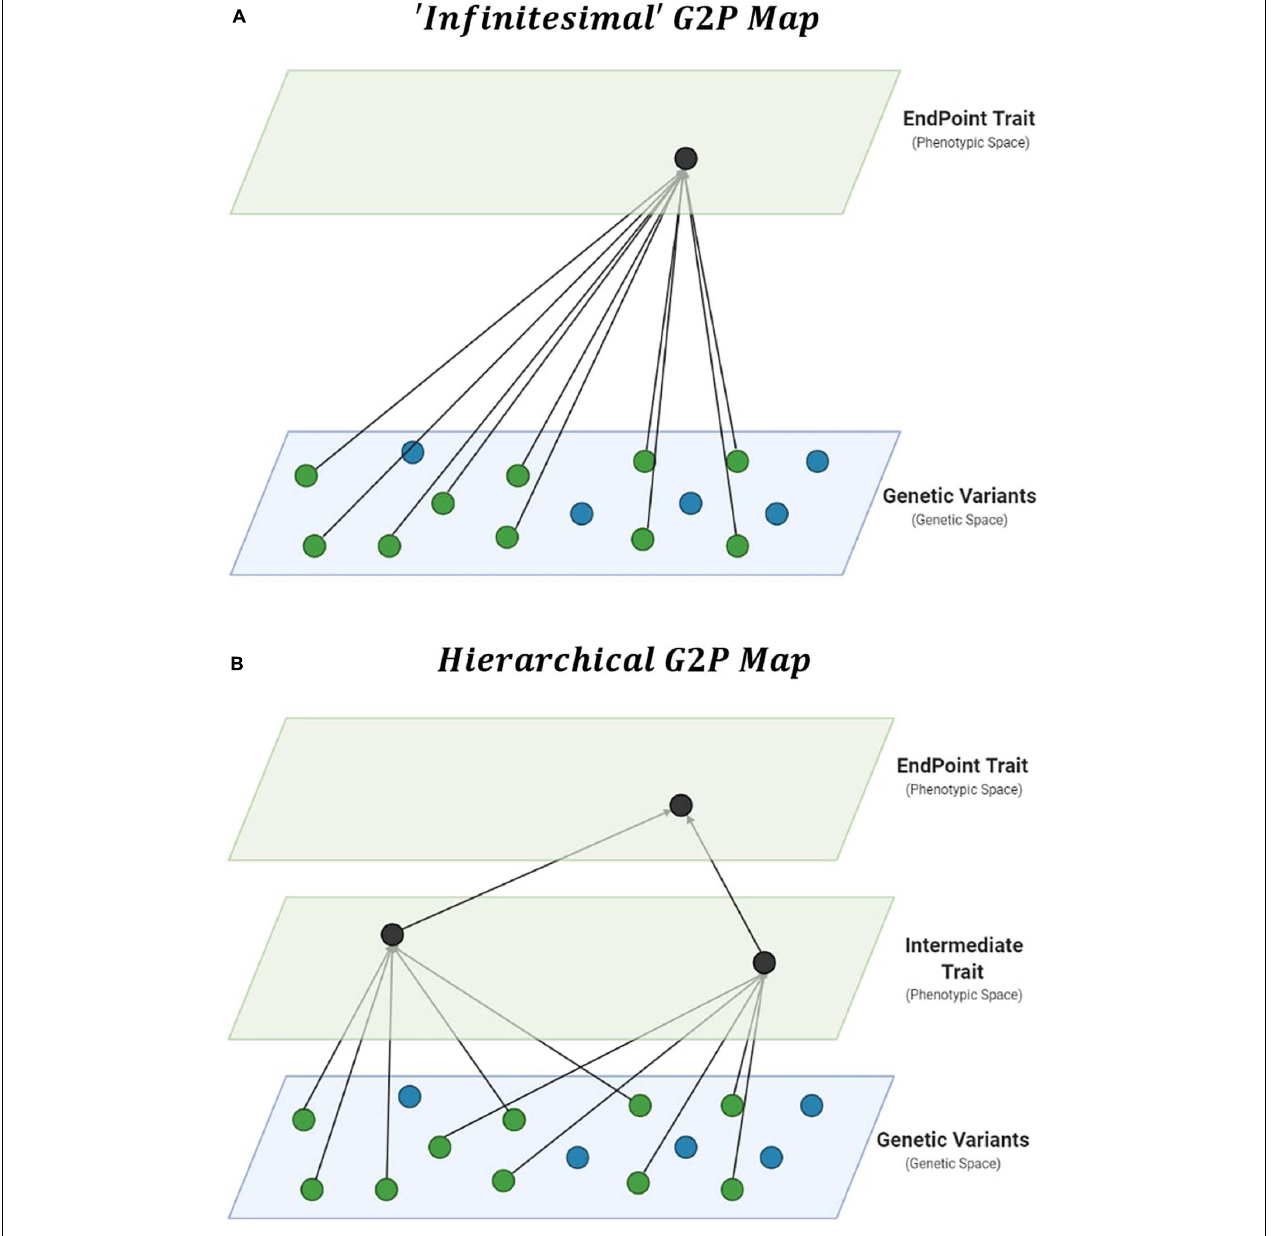
FIGURE 1 | Gene-to-Phenotype (G2P) Maps. (A) Representation of an additive infinitesimal G2P map, assuming direct effects of causal genetic variants (green circles) on complex trait phenotypes. (B) Representation of an additive hierarchical G2P map, decomposing total effects into direct effects of causal genetic variants on intermediate traits, and phenotypic effects of multiple intermediate traits on complex trait